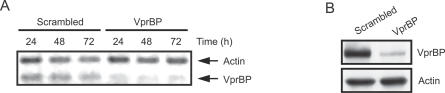
Depletion of VPRBP Using siRNAHEK293 cells were transfected with 300 pmol of VPRBP-targeting siRNA or control scrambled siRNA using Oligofectamine.(A) At 24, 48, and 72 h post-transfection, RNA was extracted and analyzed by RT-PCR to determine the extent of VPRBP downregulation at the mRNA level. PCR products were analyzed in the exponential phase of amplification. Actin levels were used as a control for RNA quality and reverse transcription efficiency.(B) Forty-eight hours after siRNA transfection, cells lysates were harvested and analyzed by Western blot using a polyclonal rabbit anti-VPRBP antibody to demonstrate the downregulation of VPRBP at the protein level. Actin levels were used as a control for protein loading.